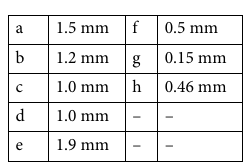
Table 1. Dimensions of the antenna